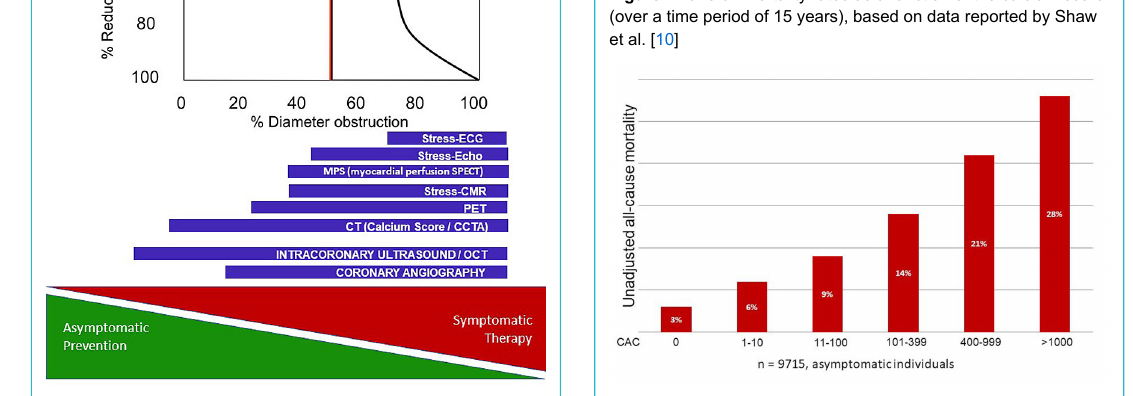
Figure 2: Overall mortality rates as a function of the calcium score (over a time period of 15 years), based on data reported by Shaw et al.